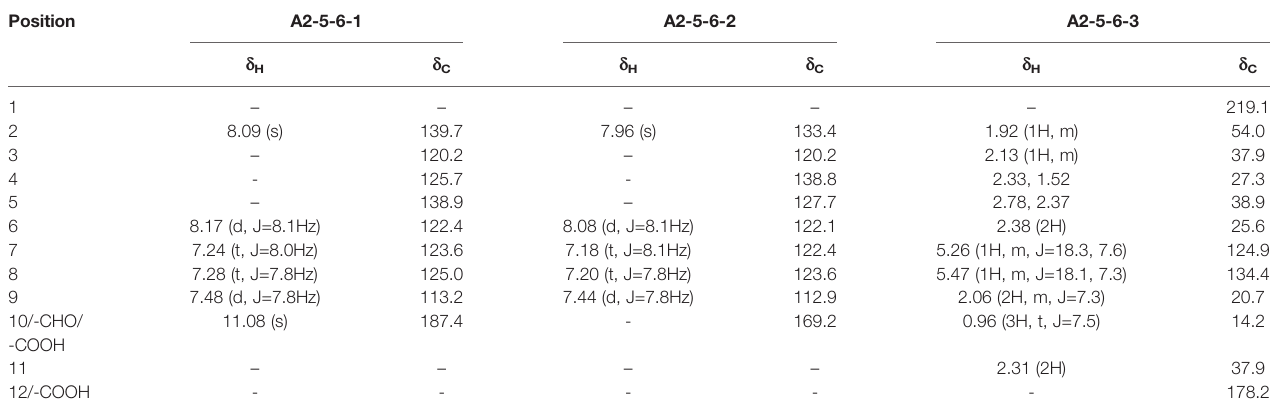
TABLE 1 | 1 H (150 MHz, CDCl 3 ) and 13 C NMR (150 MHz, CDCl 3 ) spectroscopic data of A2-5-6-1, A2-5-6-2, and A2-5-6-3.